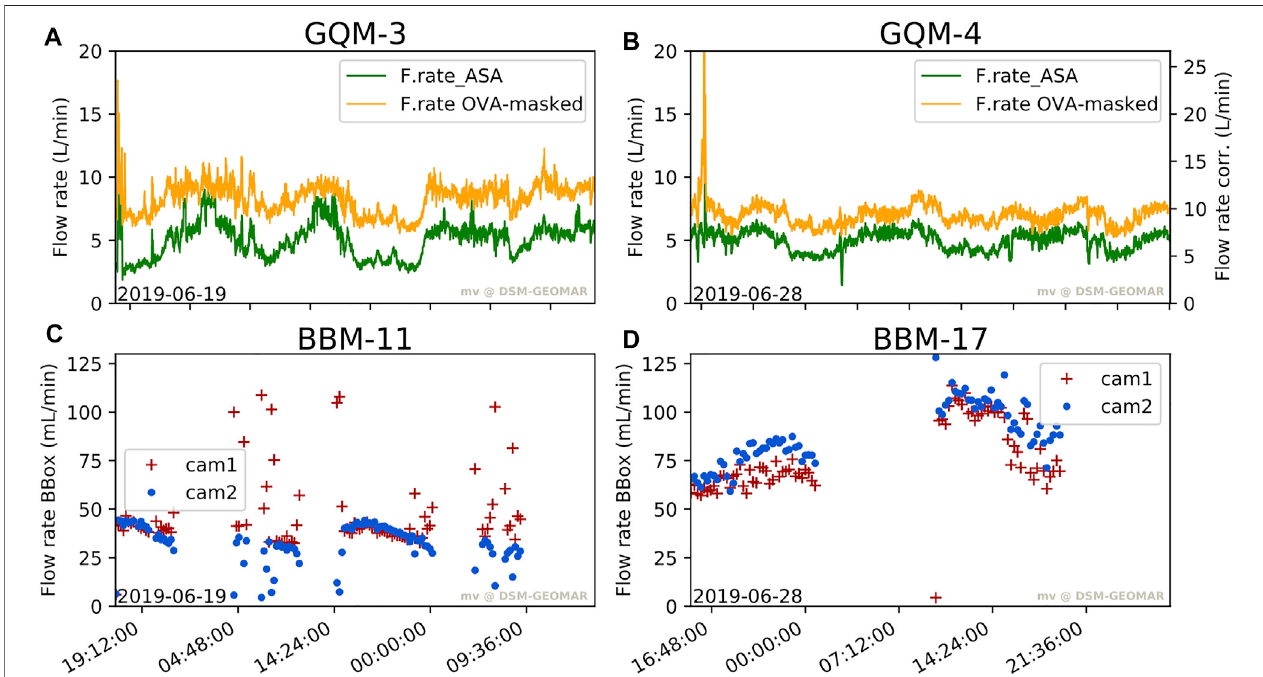
FIGURE10|(A,B) FlowratesasderivedfromASAandOVA-maskedamplitudedata-seriesand (cid:1) K 0 valueforthetwodeployments.Resultsalsoshow fl owratesfor deployment GQM-4 using the pulse length correction (B) . Flow rate of bubble streams optically measured by each camera in the two BBox deployments are shown (C,D) for visually comparing their behavior with total fl ow rates. No similarities were found.